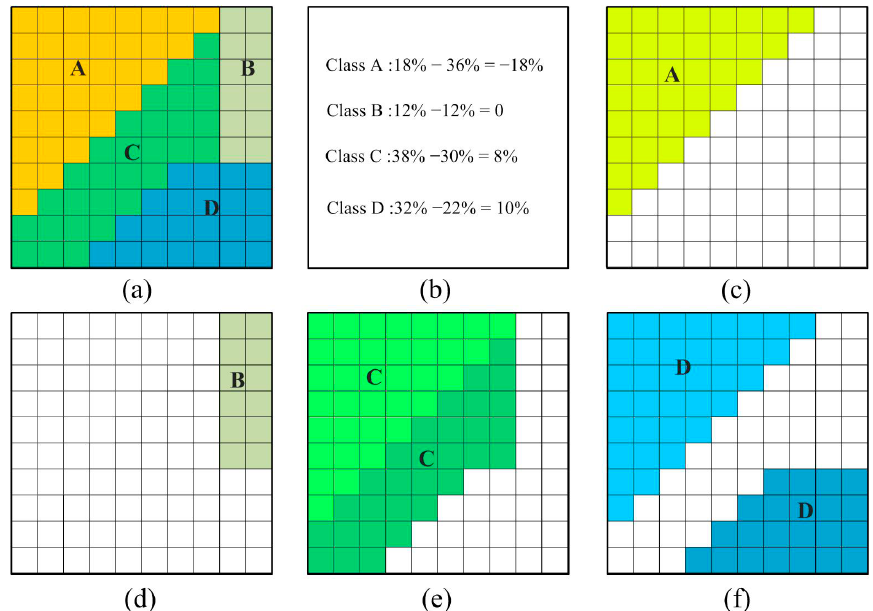
Figure 1. An example of land cover change and allocation of fine resolution pixel labels according to the transfer matrix: ( a ) former 10 × 10 fine resolution pixels within one coarse resolution pixel; ( b ) fraction change of each class; ( c ) potential fine resolution pixel locations of class A marked in yellow color in latter fine resolution map; ( d ) fine resolution pixel locations of class B marked in greyish-green color in latter fine resolution map; ( e ) fine resolution pixel locations of class C marked in dark green color and potential fine resolution pixel locations for the rest of class C marked in light green color; and ( f ) fine resolution pixel locations of class D marked in dark blue color and potential fine resolution pixel locations for the rest of class C marked in light blue color.